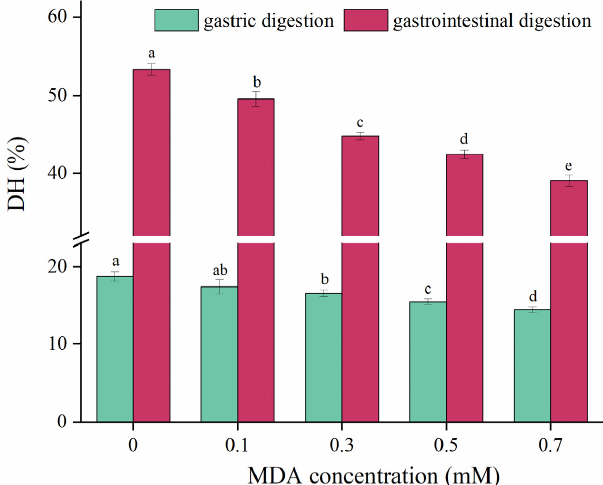
Figure 5. Effect of MDA on MP gastric and gastrointestinal digestibility. Different letters (a, b, c, d, e) indicate a significant difference ( p < 0.05, n = 5). indicate a significant difference ( p < 0.05, n =